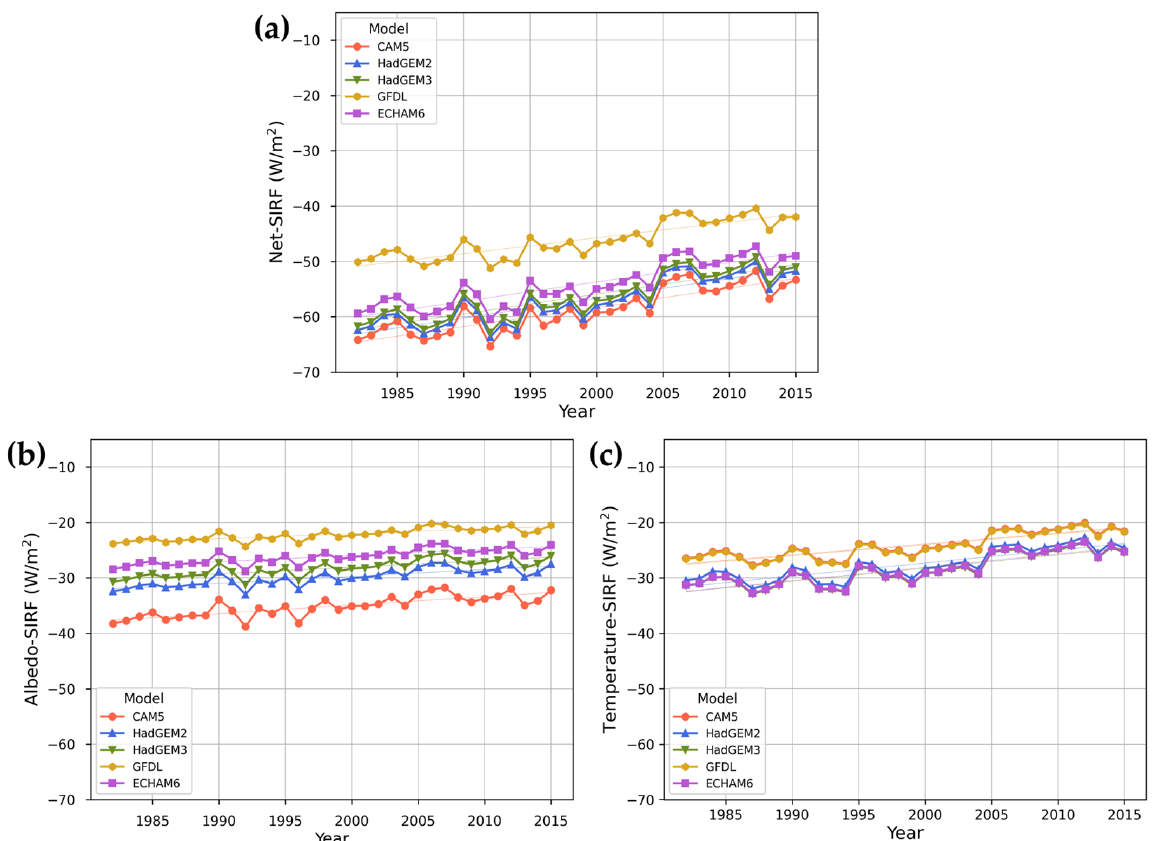
Figure 3. Time series distribution of annual average SIRF according to the GCMs from 1982 to 2015 in the Arctic: ( a ) net-SIRF, ( b ) albedo-SIRF, ( c ) temperature-SIRF.